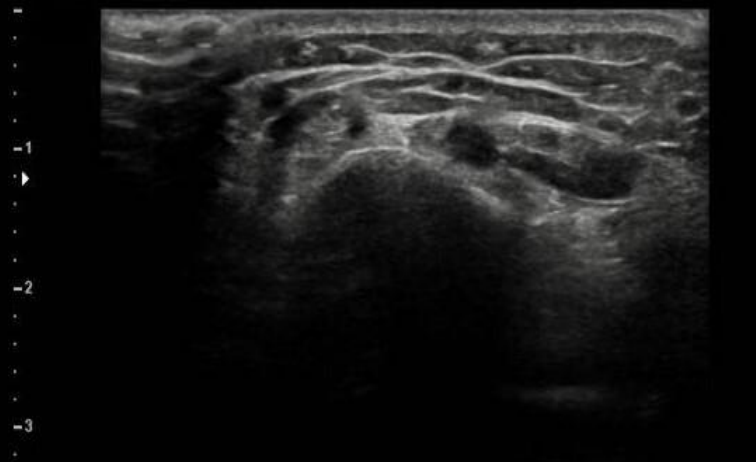
Figure 2. Doppler ultrasound of the wrist: thickening of the subcutaneous soft tissues associated with a minimal flap of effusion in accordance with the tendon sheath of the extensor tendons of the fingers is seen. No further alterations that can be evaluated with this method are observed.